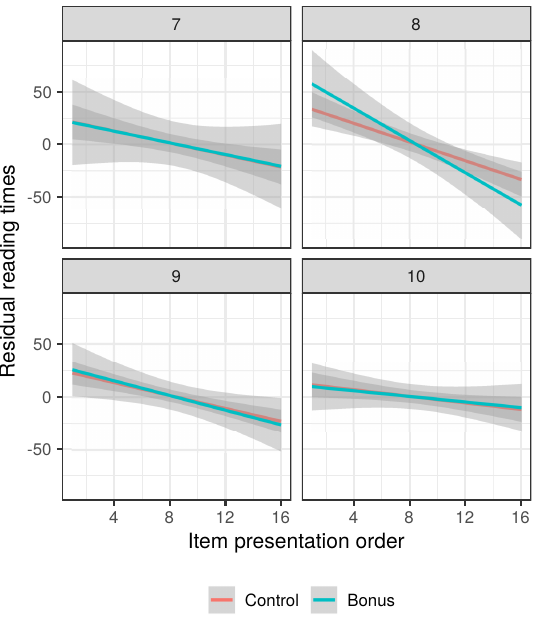
Figure 3. Effect of repeated exposure and reward differential in spill-over region 8. For completeness, a region-by-region plot with the plain residual reading times is provided in Figure 4. The behaviour of the two groups of participants was generally the same, except that the Bonus group slowed down at region 5 (approaching the critical region), and exhibited greater variability than the Baseline group, which is consistent with participants being more attentive and taking greater care to perform the